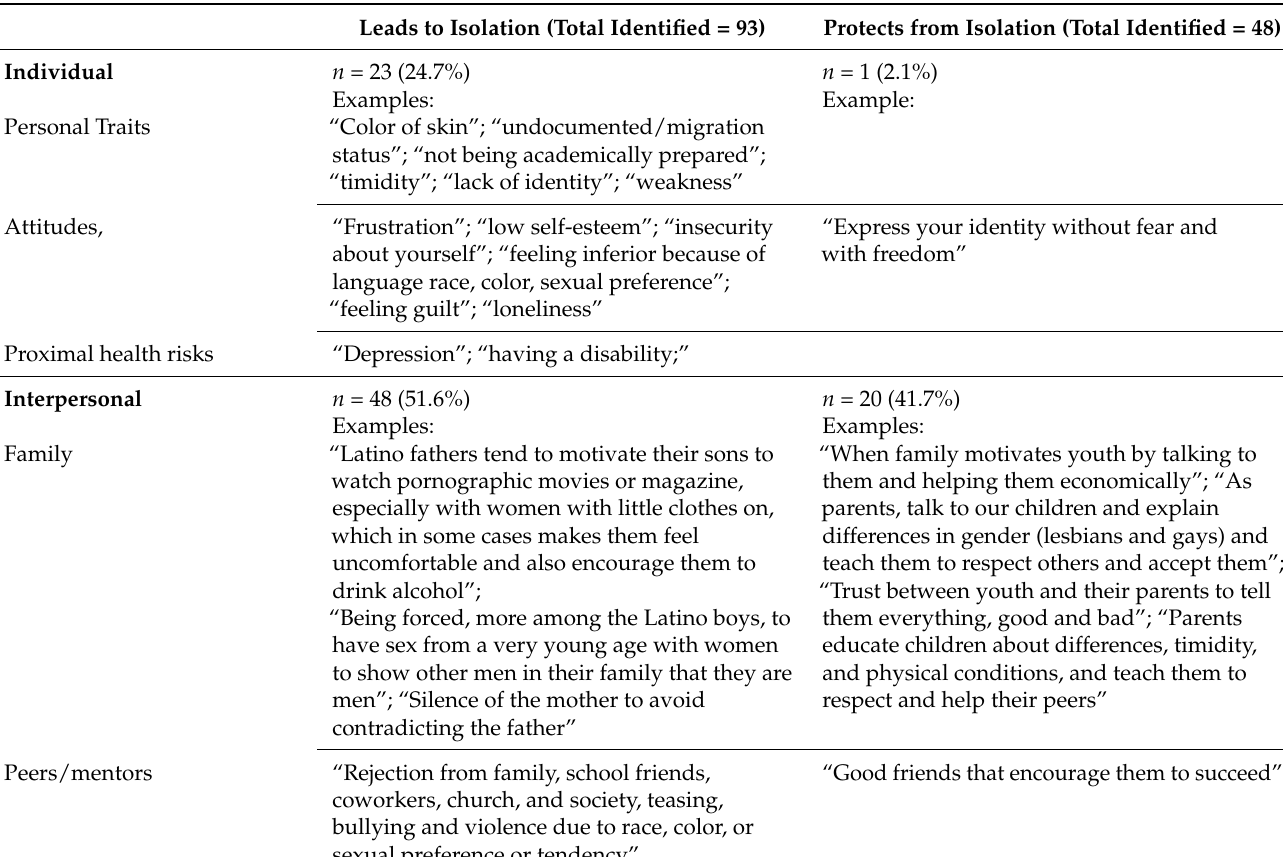
Table 4. Latinx 4-H Parents’ Perspectives on Social